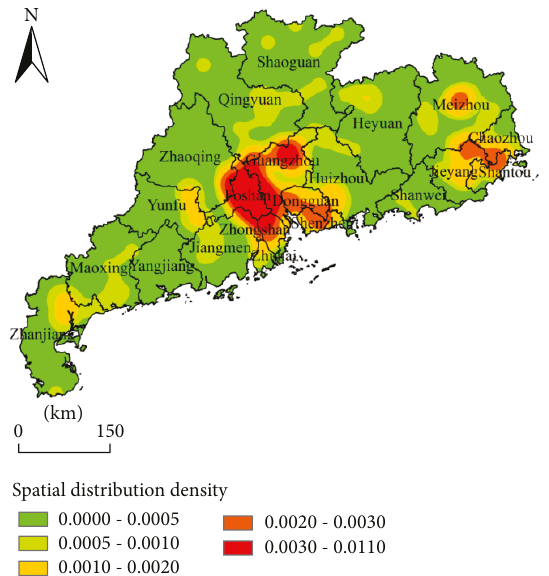
Figure 3: Estimation of nuclear density of Characteristic Towns in Guangdong